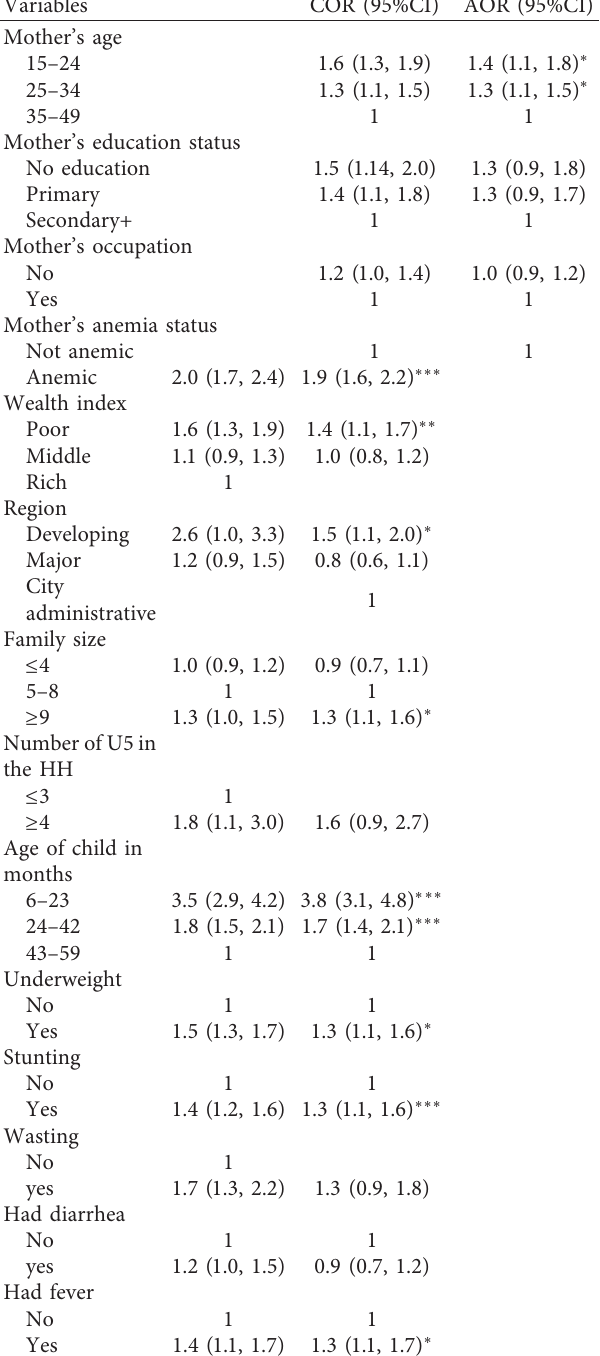
Table 2: Factors associated with anemia among children aged 6–59 months in Ethiopia, 2016